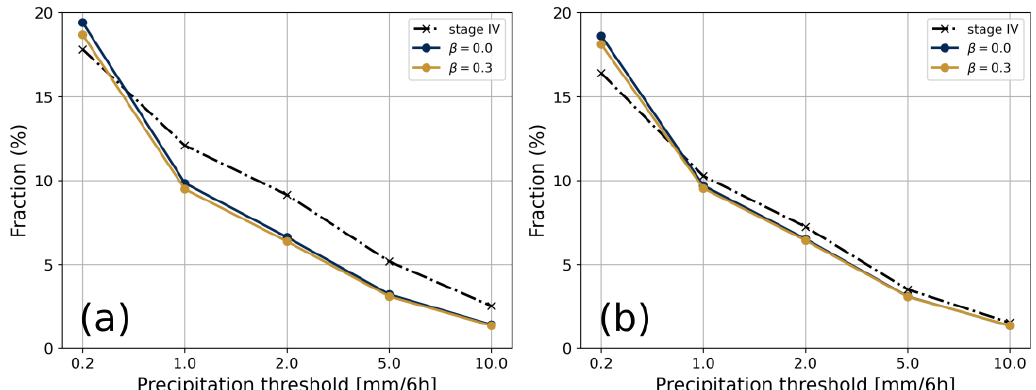
Figure 6. The fractional areal coverage (%) of the 6h accumulated precipitation meeting or exceeding selected thresholds ( x axis) during the summer (a) and the winter (b) for ST4 (dashed black line) and CaPA using the configuration with β = 0 . 0 (blue line) and β = 0 . 3 (yellow line) over their common domain (Fig. 5).